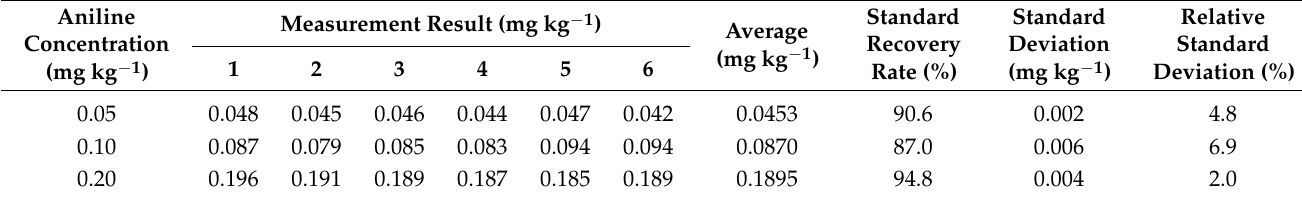
Table 3. The precision and accuracy of the method (intra-day n = 6, on the same day).